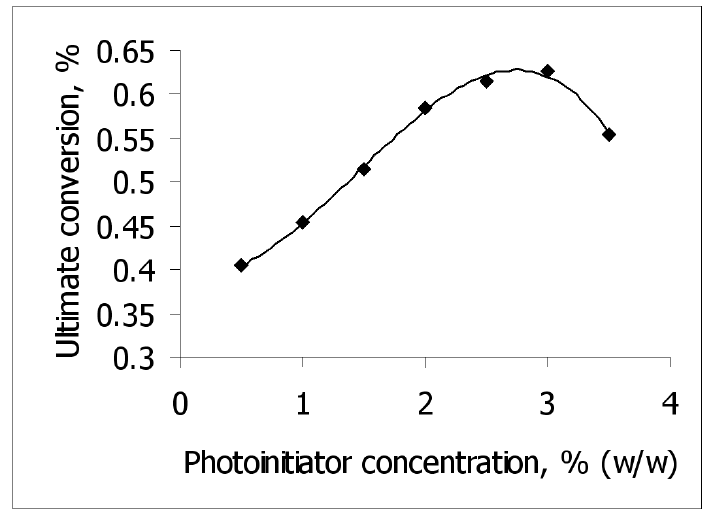
Fig. 10 Ultimate conversion vs. photoinitiator concentration at 30 ◦